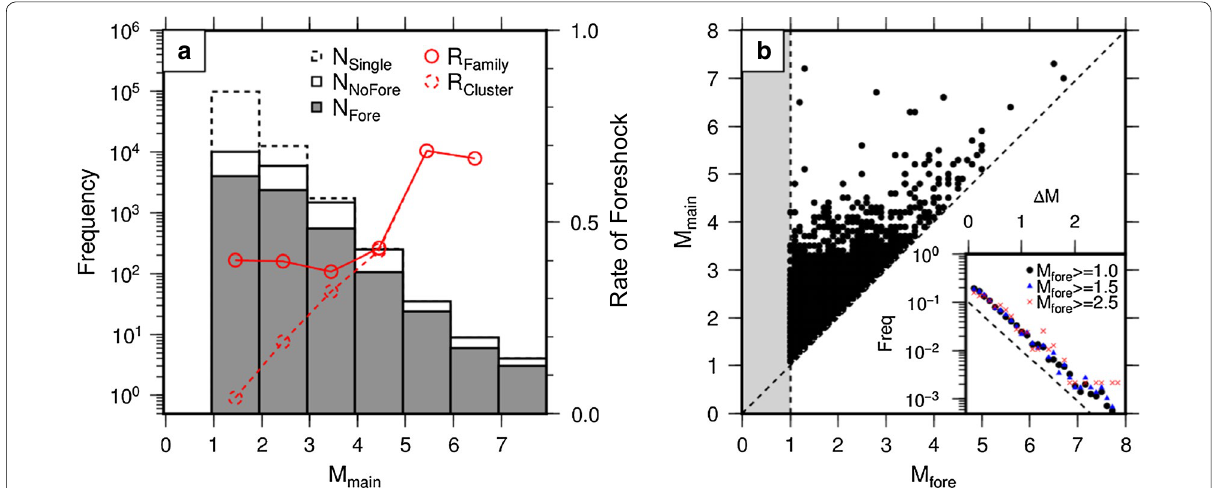
Fig. 6 Frequency–magnitude distribution and relationship between the largest foreshock and its mainshock for the long-term data. a Frequency– magnitude distribution and percentage of foreshock occurrence. The white solid and dashed histograms show the frequency of mainshocks versus their magnitude for all families (without singles) and clusters (with singles), respectively; the gray histogram shows the frequency of mainshocks that are accompanied by foreshocks (left axis). The red solid and dashed lines show the proportion of sequences that have foreshocks for all families and clusters, respectively (right axis). b Relationship between the magnitude of the largest foreshock and the corresponding mainshock magnitude for each earthquake cluster. The gray shading indicates M 1.0 (potentially incomplete data). The lower right inset shows the frequency distribution ≤ of the magnitude difference between the mainshock and largest foreshock. The dashed line has a slope of 1.0. The black dots, blue triangles, and red crosses indicate that the magnitude of the largest foreshock is above 1.0, 1.5, and 2.5,